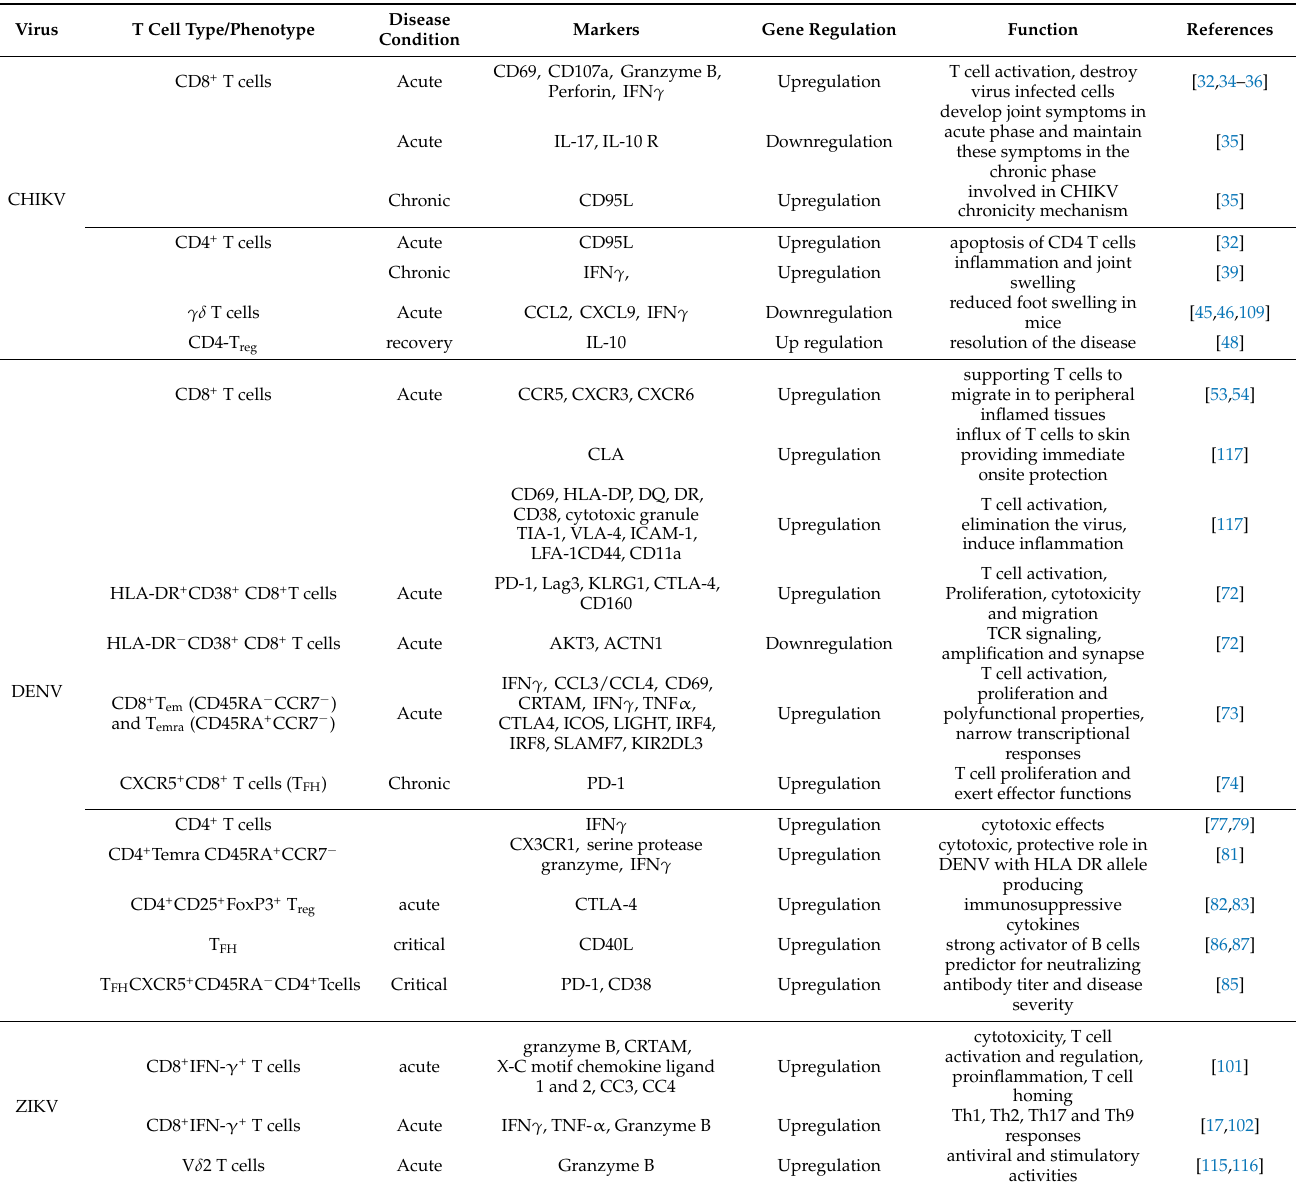
Table 1. The role of T cell populations of CHIKV, DENV and ZIKV during different disease stages, and their respective function, gene expression and regulation